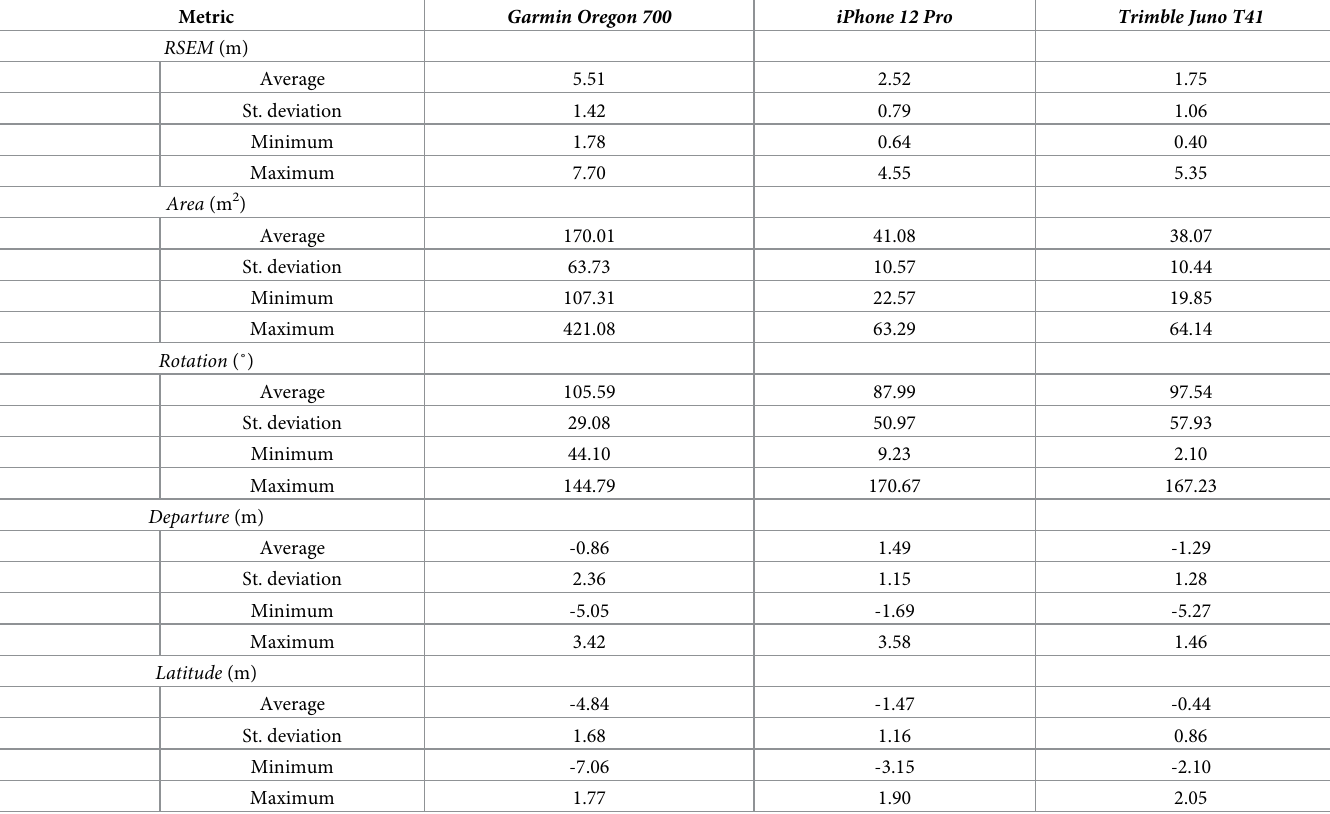
Table 4. The summary of elliptical metrics from measurements obtained by different GNSS receivers.